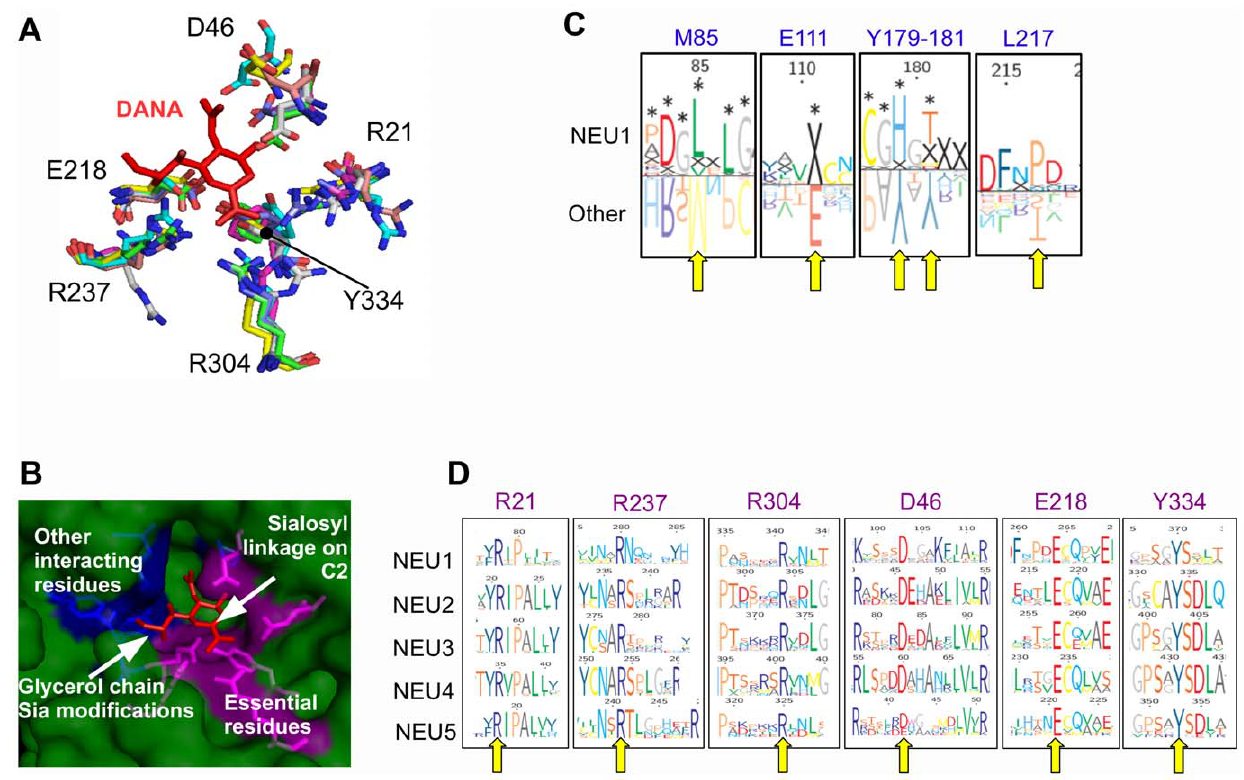
Figure 1. Analysis of sialidase catalytic crevice. (A) The superimposition of the structural models obtained for sialidase enzymes showed that the localization of the 6 key residues (those essentials for catalysis) within the protein structure is well conserved. The enzyme competitive inhibitor DANA is depicted in red. (B) Surface representation of the catalytic crevice in human NEU2 structure. Key residues, in magenta, are located near the C1 carboxyl group and the C2 (hemiketal carbon of Sias involved in the formation of the sialosyl linkage), while other residues interacting with the substrate, in blue, interact with the C-4 hydroxyl group, C-5 acetamido group and glycerol side-chain of DANA, where most of the natural Sia modifications occur. (C) Analysis of the 5 amino acid residues interacting with the competitive inhibitor DANA but not essential in the catalytic process, as identified from human NEU2 crystal structure. Subfamily LOGO analysis comparing NEU1 subgroup with other sialidase subgroups revealed specific differences on these 5 residues. X indicate missing residues and significant differences are marked with *. L217 shows no subgroup specific conservation in this comparison. (D) LOGO representations of the multiple alignments of the five sialidase subgroups show high sequence conservation for all the 6 key residues involved in the catalytic process. Yellow arrows in (C) and (D) indicate the considered residues. Residues are numbered according to human NEU2 protein sequence. The same color code is used in panels (B), (C) and (D) to indicate the residues that coordinate